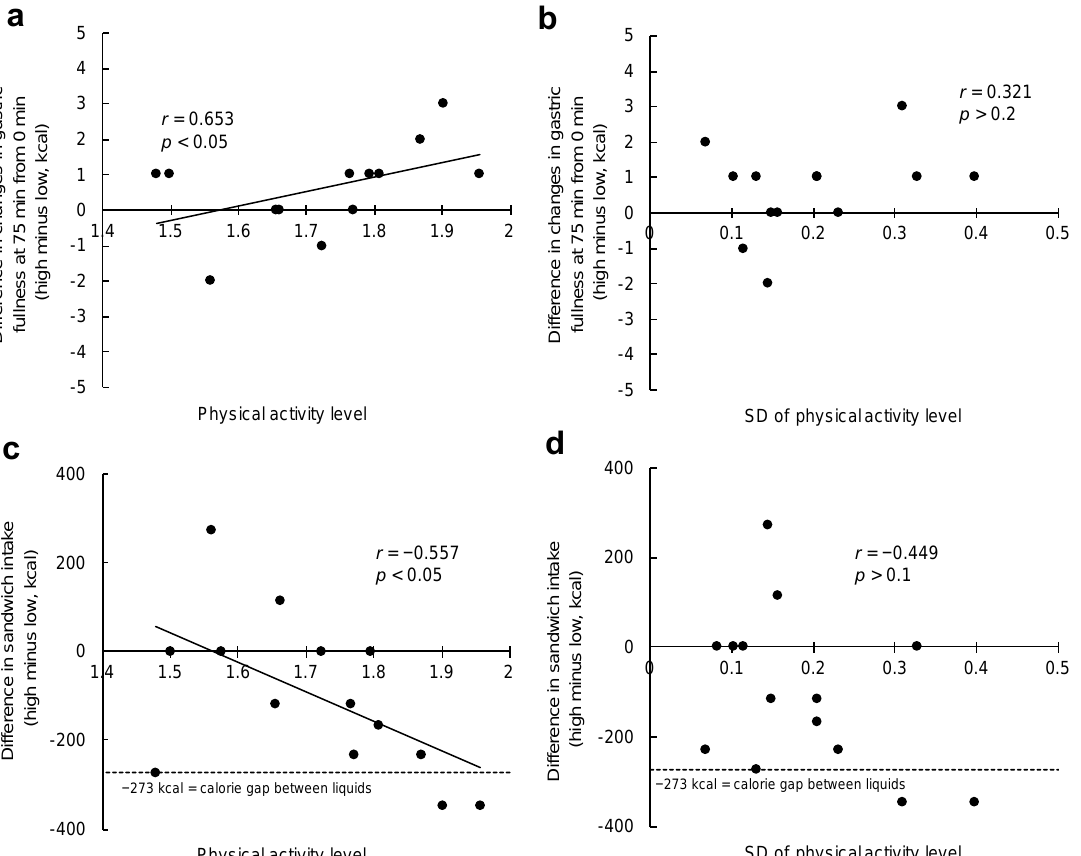
Figure 2. Association between physical activity and the di ff erence in change in subjective appetite or energy intake from sandwiches between the two conditions. ( a ) Scatter plots between physical activity level and the di ff erence in change in gastric fullness at 75 min (from 0 min). ( b ) Scatter plots between SD of physical activity level and the di ff erence in change in gastric fullness at 75 min (from 0 min). ( c ) Scatter plots between physical activity level and the di ff erence in the energy intake from sandwiches. ( d ) Scatter plots between SD of physical activity level and the di ff erence in the energy intake from sandwiches.